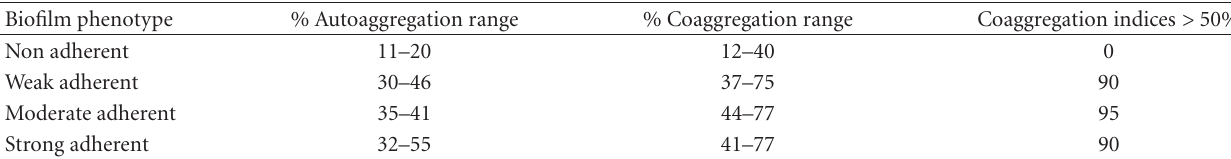
Table 2: Listeria ivanovii isolates with coaggregation indices > 50% among the four biofilm